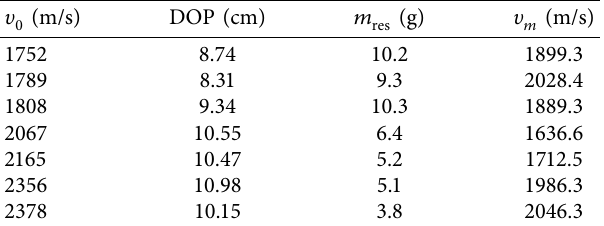
Table 2: Calculated υ m with different experimental